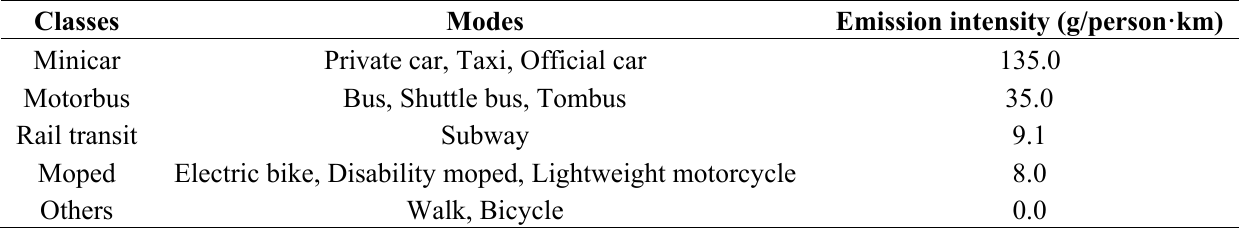
Table 1. CO 2 emission intensity by transport